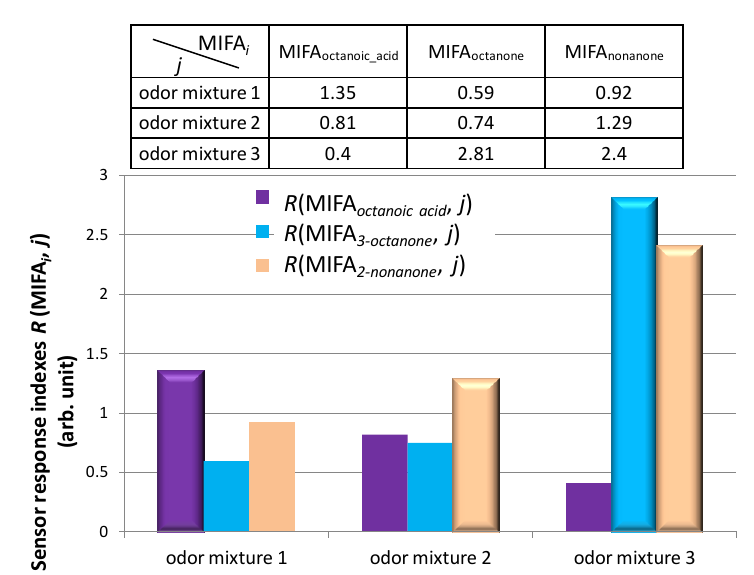
, j ) to odor mixture j obtained using the i